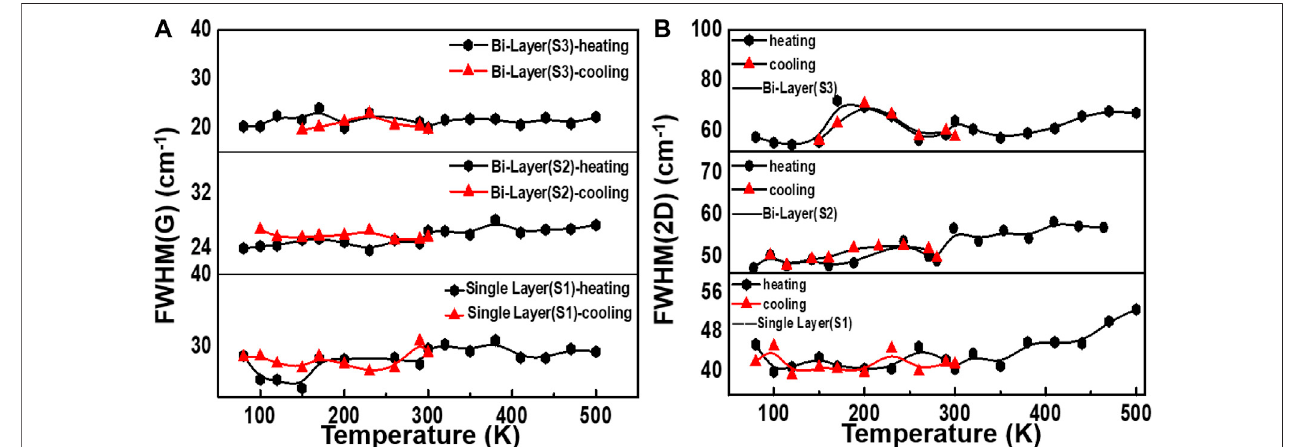
FIGURE 5 | FWHM changes for different samples during temperature changes. (A) Change of FWHM of the G peak during the heating and cooling process. (B) FWHM (2D) of single- and bilayer graphene with two growth ways as a function of